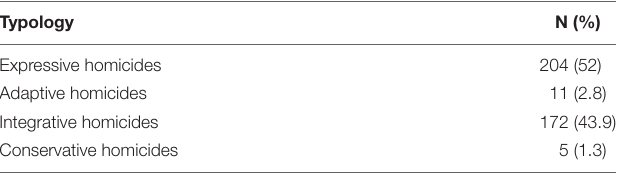
TABLE 2 | Classification of cases in a dominant